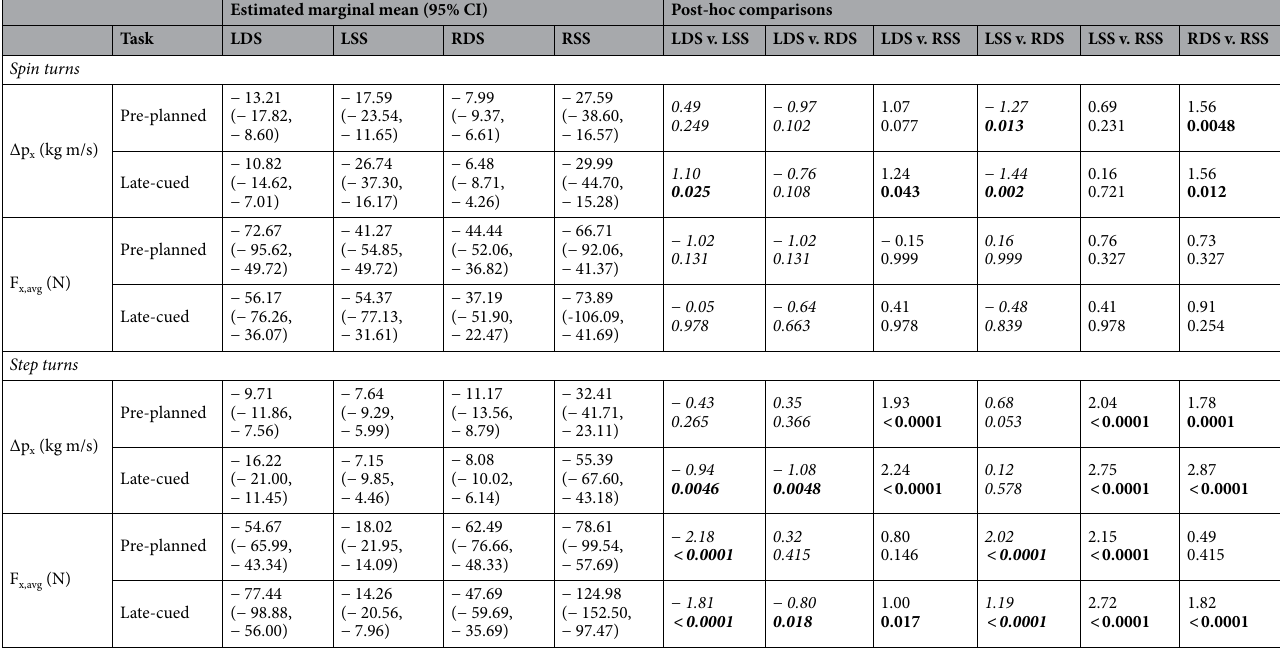
Table 4. Group-level estimated marginal means for linear study outcomes from linear mixed models by turn strategy. Acronyms: Left Double Support (LDS) Left Single Support (LSS), Right Double Support (RDS), Right Single Support (RSS), change in global X-axis linear momentum (∆p x ), and global X-axis average force (F x,avg ). Negative values are leftward in the direction of the turn. Bolded p-values indicate statistically significant differences. Italic text indicates comparisons that were not related to the right single support phase that was pertinent to the hypothesis.